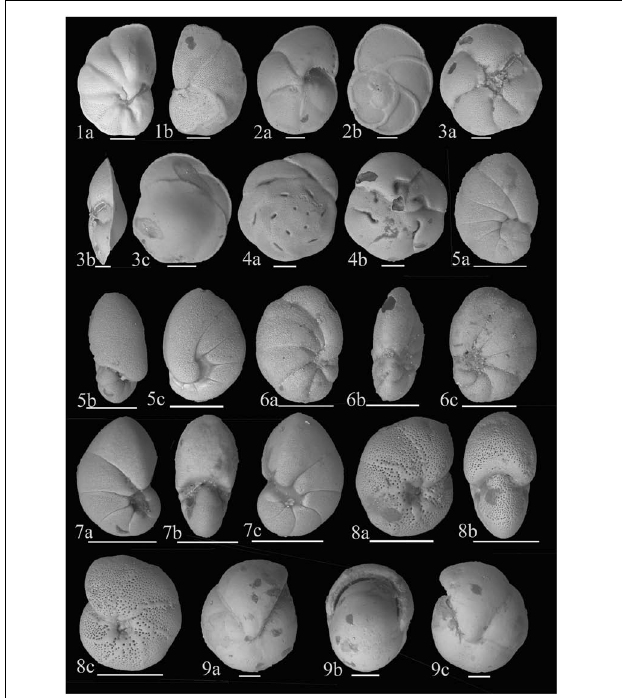
FIGURE 5 | (1) Cancris oblongus (Williamson, 1858); (a) Ventral view (b) Dorsal view; (2) Eponides cribrorepandus (Asano and Uchio, 1951); (a) Ventral view (b) Dorsal view; (3) Gavelinopsis mira (Cushman, 1922); (a) Ventral view (b) Lateral view (c) Dorsal view; (4) Pseudoeponides japonicum (Uchio, 1950); (a) Dorsal view (b) Ventral view; (5) Nonionella auris (d’Orbigny, 1839); (a) Side view (b) Apertural view (c) Side view showing the last chamber flap covering the umbilicus; (6) Nonionella limbato-striata (Cushman 1931); (7) Nonionellina labradorica (Dawson, 1860); (a,c) Side views (b) Apertural view; (8) Melonis (?) chathamensis (McCulloch, 1977); (a,c) Side views (b) Apertural view; (9) Pullenia bulloides (d’Orbigny, 1846); (a,b) Side views (c) Apertural view. Scale bar is 100 µ m.